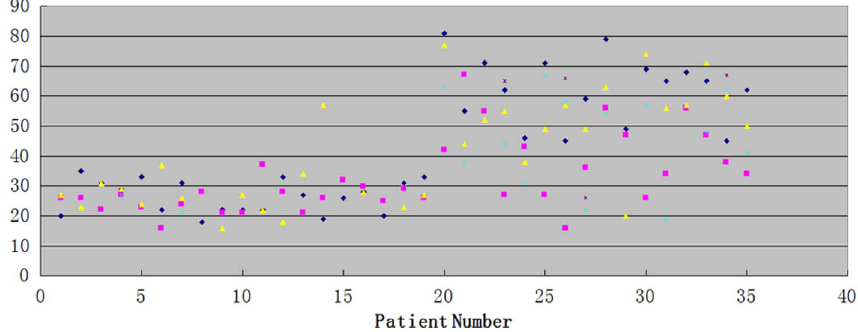
Figure 2. A plot of the T2* values of metastatic and benign axillary lymph nodes for each patient. The horizontal axis indicates the patient number, and the vertical axis indicates the T2* values.